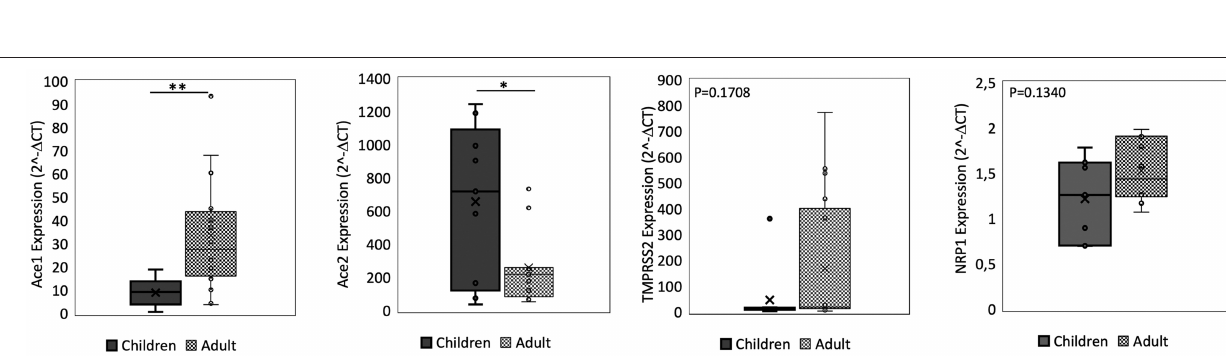
FIGURE 1 | qPCR analysis of Angiotensin I Converting Enzyme ( ACE1 ), Angiotensin II Converting Enzyme ( ACE2 ), Transmembrane Serine Protease 2 ( TMPRSS2 ), and Neuropilin-1 (NRP1 ) genes in nasal epithelium from children and adult subjects. Comparative expression of ACE1 , ACE2 , TMPRSS2 , and NRP1 in nasal epithelium of children ( n = 15) and adult subjects ( n = 15). Data analysis was performed using the comparative threshold cycle (CT) method and expressed as 2 ∧ -delta CT. Gene expression was normalized against the expression of the reference gene hypoxanthine phosphoribosyltransferase 1 ( HPRT ). Data are expressed as median ± SD, the X in the bars indicates mean values. P -value are reported in the graphs; significant differences are indicated as * p < 0.01; ** p < 0.005.